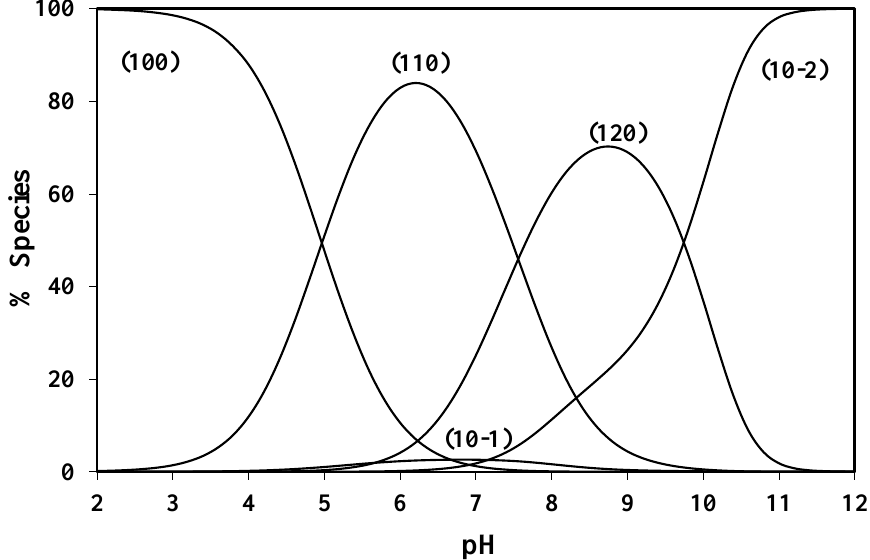
Figure 7. Concentration distribution of various species as a function of pH in the (BHEP)Pd-Bip- Pd(BHEP)-Uracil system at a concentration of 0.75 and 1.5 mM for (BHEP)Pd-Bip-Pd(BHEP) and Uracil, respectively.